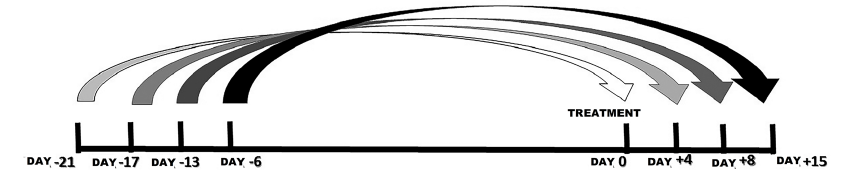
Figure 1. Organogram showing the infestation days (Day -21, -17, -13 and -6) of the cattle with Rhipicephalus microplus larvae and the respective days of collecting engorged females (Day 0, +4, +8 and +15) as of the treatment with